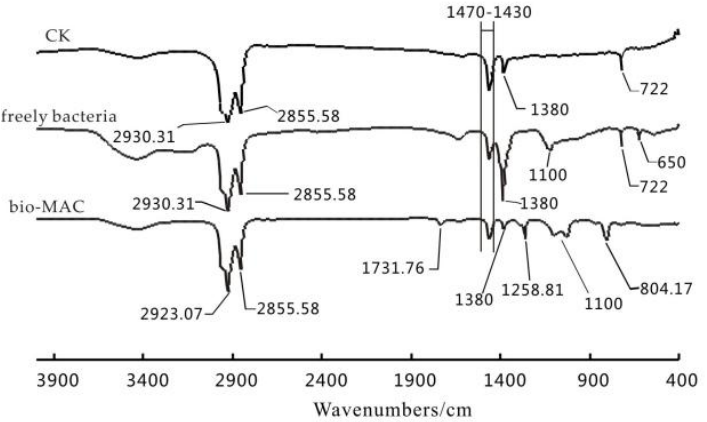
Figure 6. FTIR spectra of the residue diesel oil in wastewater after degradation using bacteria and bio-MAC.